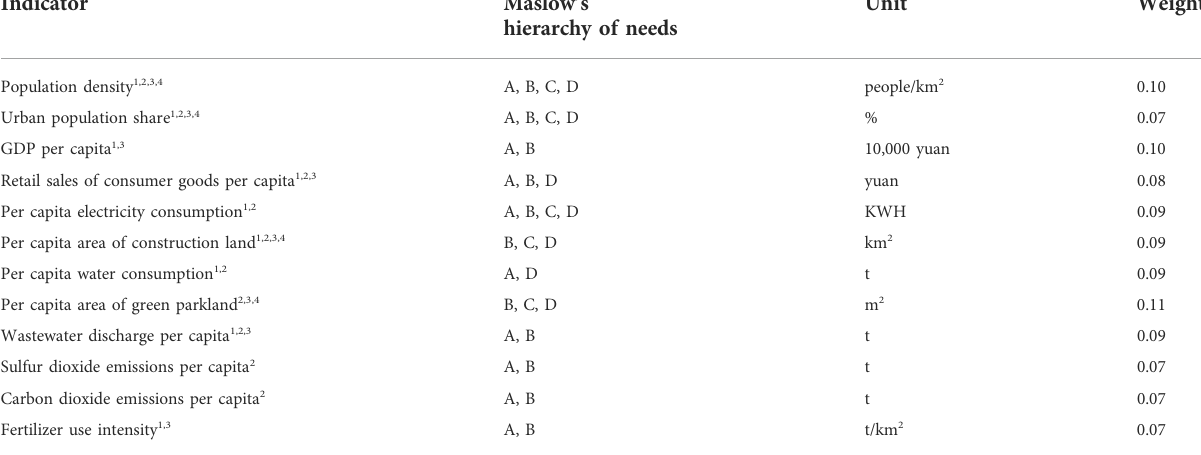
TABLE 2 Human demand indicator